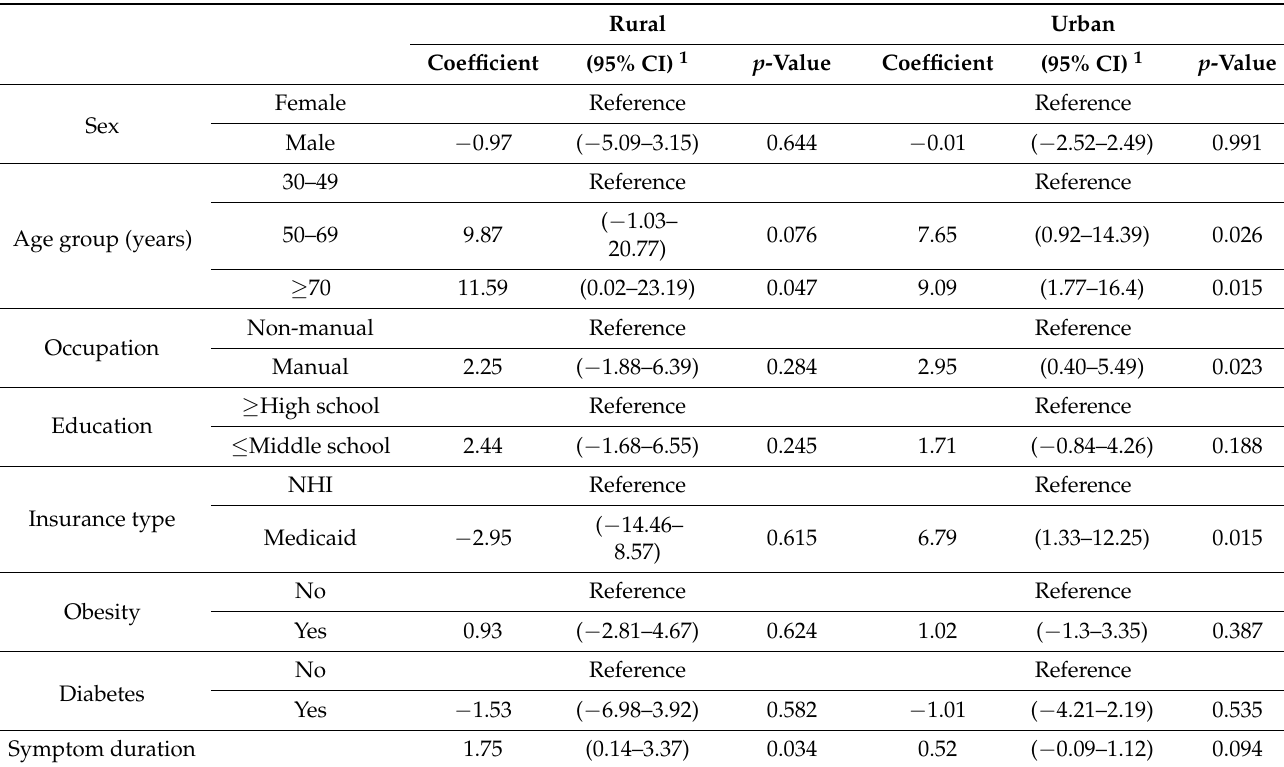
Table 4. Influence of factors on the size of the rotator cuff tear according to urban and rural residence.